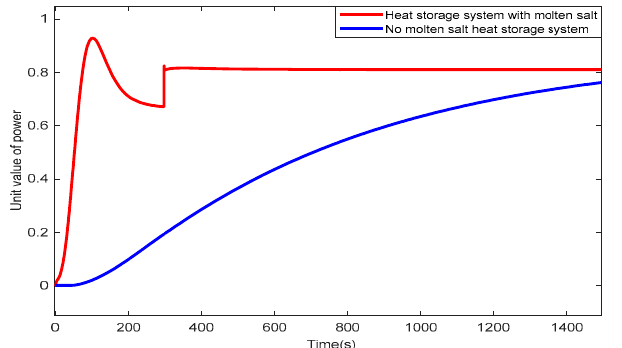
Figure 10. E ff ect of the thermal system on the output power of the molten salt reservoir. Figure 10. Effect of the thermal system on the output power of the molten salt